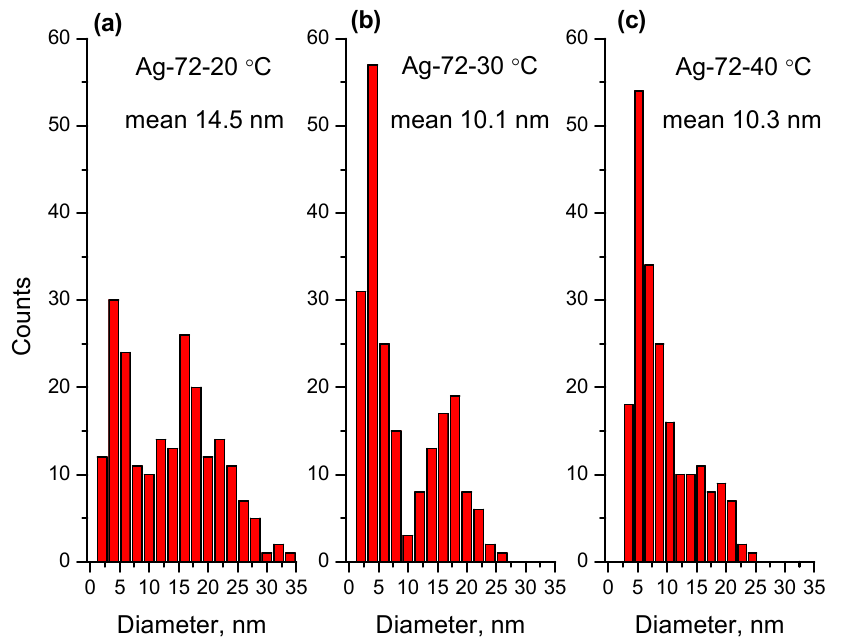
Figure 4. Size distribution for the samples ( a ) Ag-72-20 ° C, ( b ) Ag-72-30 ° C and ( c ) Ag- 72-40 ° C.